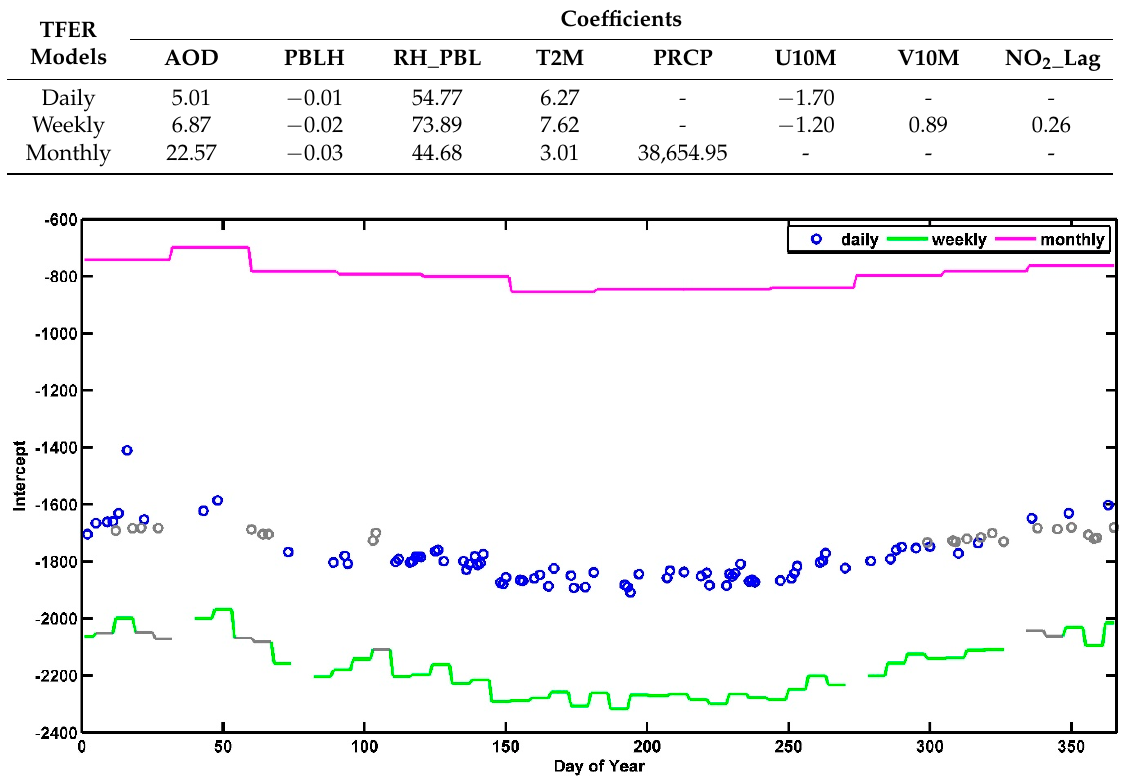
Figure 4. Variations of daily, weekly, and monthly intercepts of the first-stage nested TFER model. (N.B. Grey color indicates that the value was not statistically significant at α = 0.05).